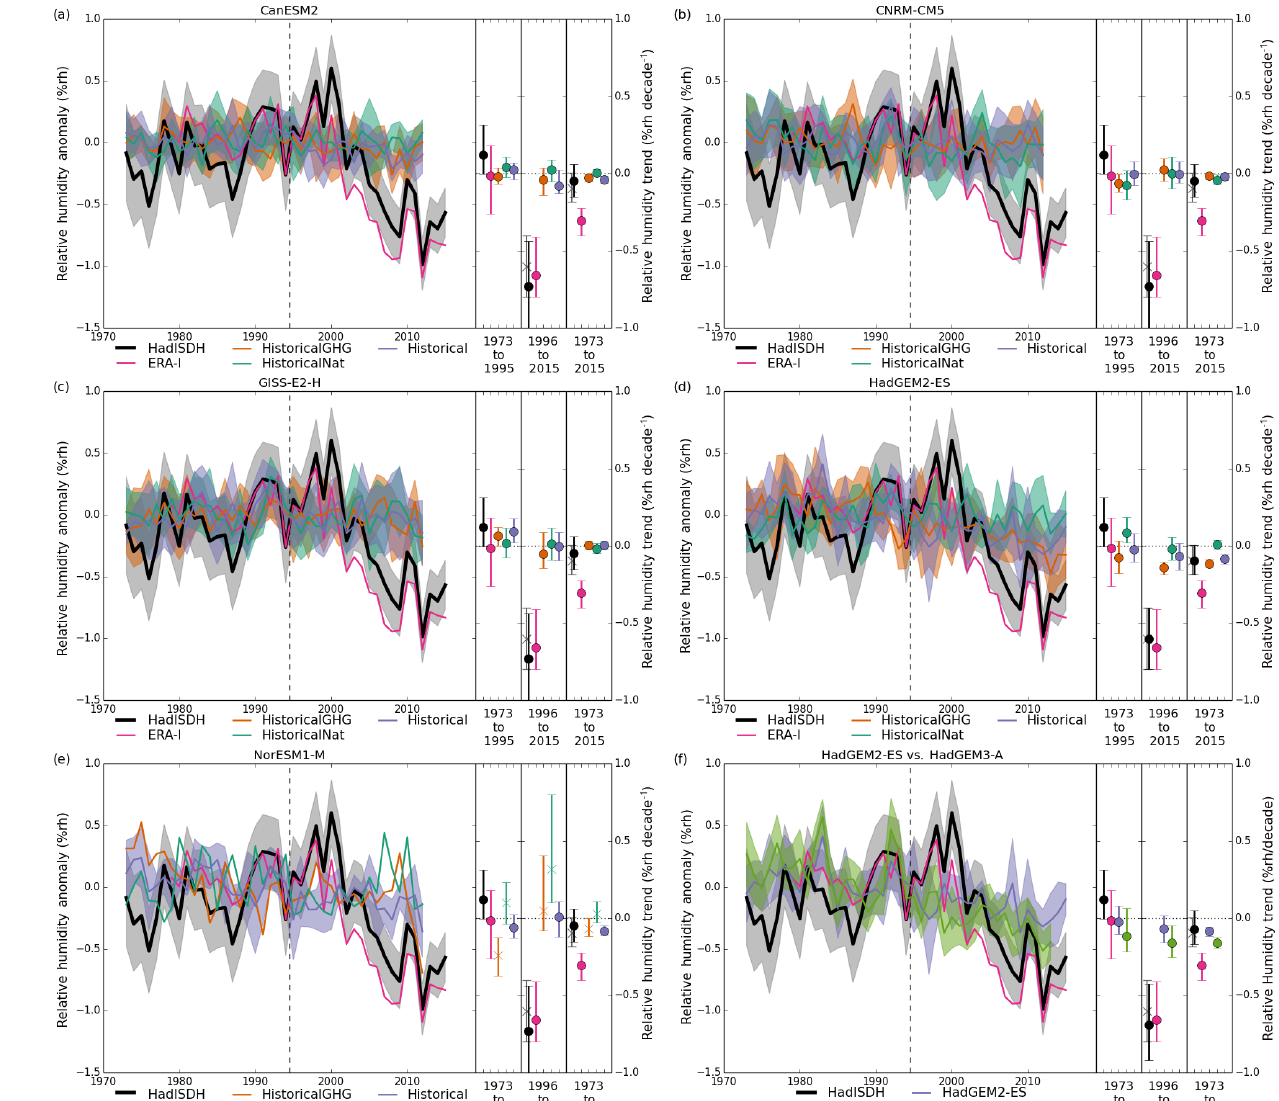
Figure 4. Global annual time series for relative humidity for five of the nine CMIP5 models and HadGEM3-A, using a climatology period of 1976–2005. HadISDH is shown by the thick black line, ERA-Interim by the magenta line, and the historical, historicalNat, and historicalGHG ensemble averages by the purple, green, and orange lines respectively. The uncertainty ranges are shown using the coloured shading. The three scatter plots in the right-hand side of each panel show the values of the linear trends for HadISDH, ERA-Interim and the ensemble averages of all three experiments for the early (1973–1994), late (1995–2015) and full periods. For the late and full period panels, the HadISDH trend is shown matching the temporal coverage of the historical model (circle) and its full coverage (cross). If there is only one ensemble member for the model, then the trend is marked with a cross rather than